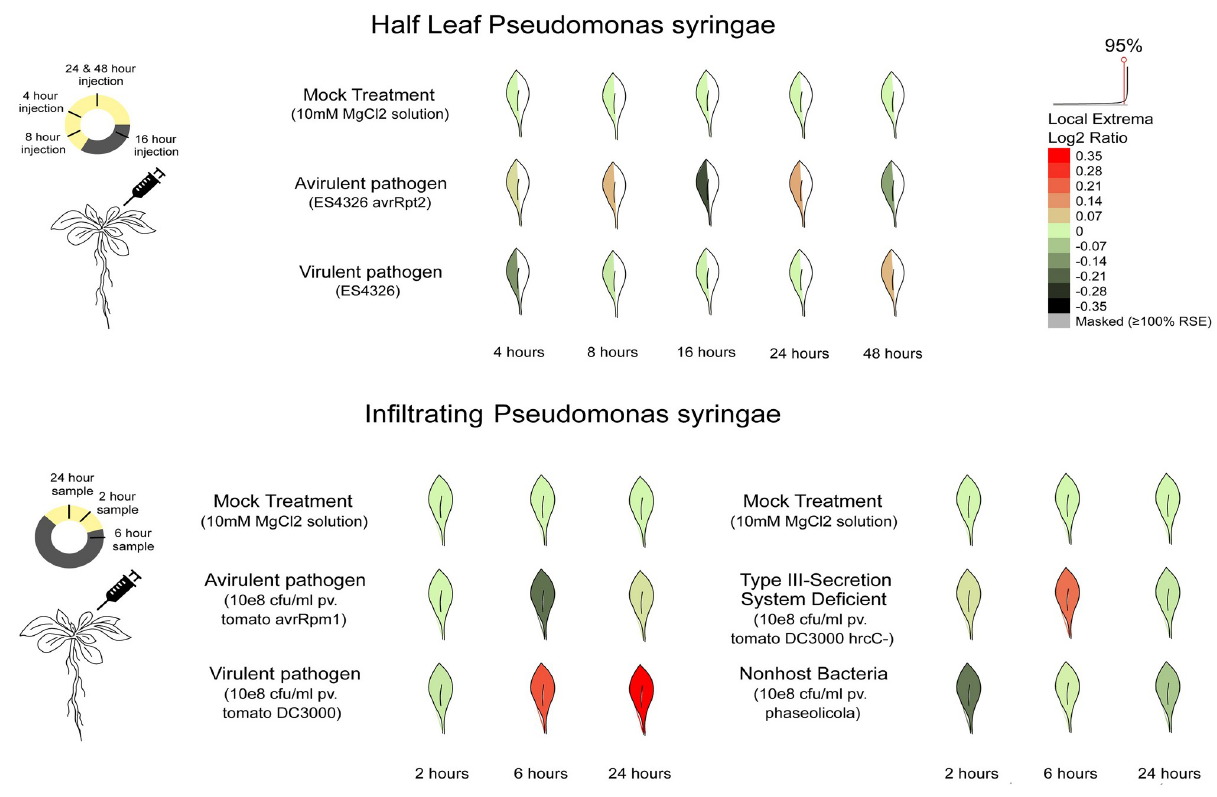
Fig 4. ACD11 gene expression in different biotic